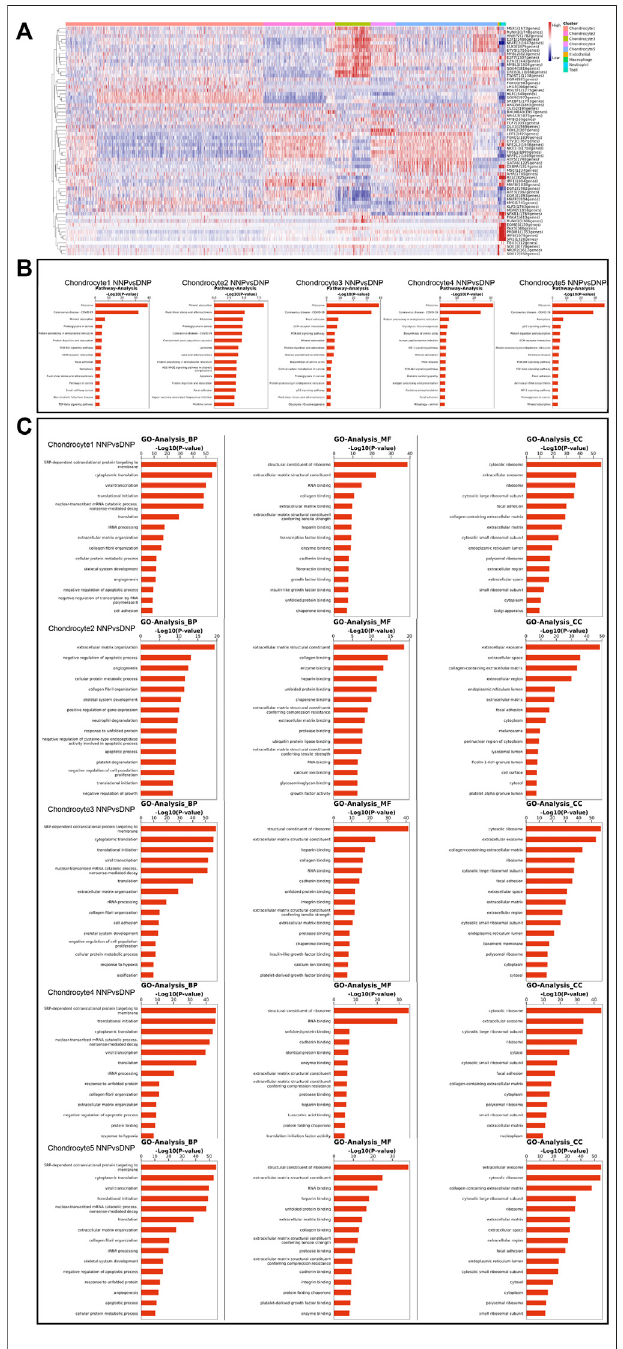
FIGURE 8 | Gene Regulatory Network, Gene Ontology analysis, and pathway analysis in the nucleus pulposus cells. (A) Heatmap of the AUC scores of transcription factor expression regulation by SCENIC. (B) A barplot showing the signaling pathways of interest in NP cell as detected by CellChat. (C) A barplot showing the Gene Ontology analysis of NP cell including biological process, molecular function, and cellular component.